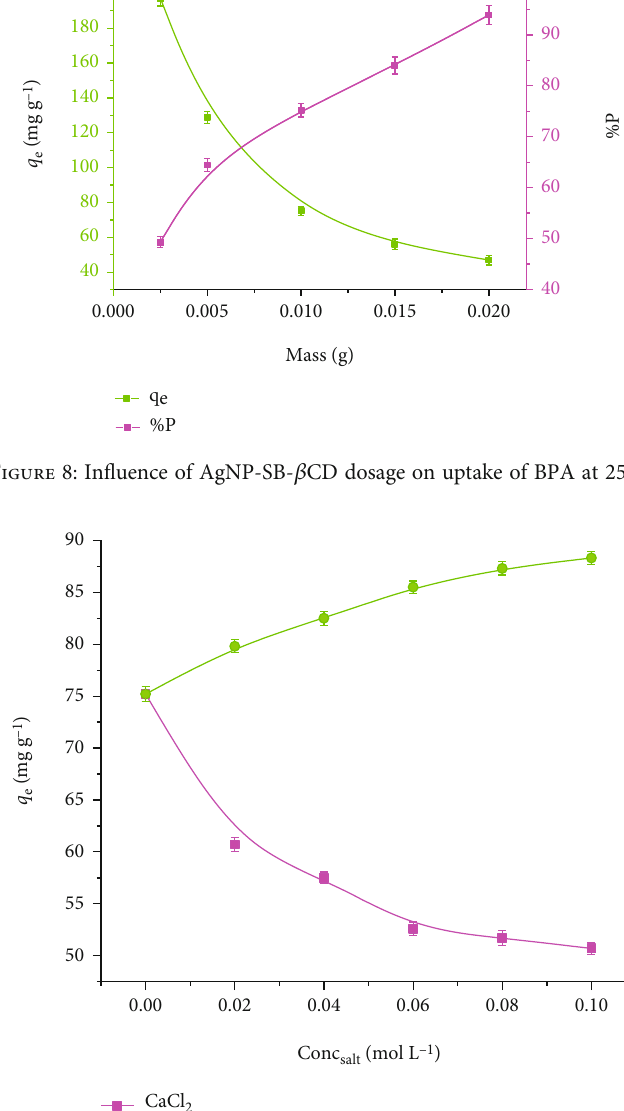
Figure 9: In fl uence of ion interference on uptake of BPA onto AgNP-SB- β CD nanocomposites ( C T = 25 ° C, and t = 120 min).